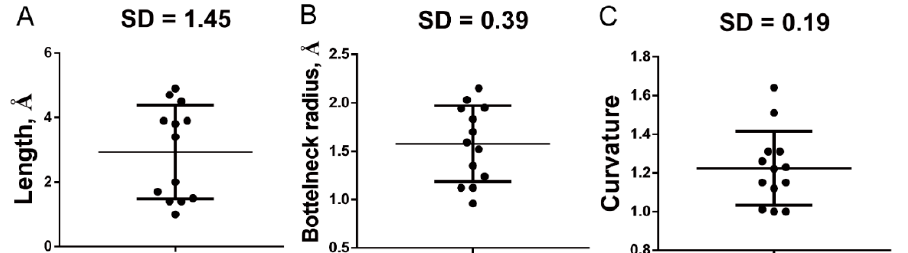
Figure 5. Shape parameters of the catalyzing pockets of structured rhodaneses. The rhodanese structures were downloaded from PDB database (Table S1). The length ( A ), bottleneck radius ( B ) and curvature ( C ) parameters of their catalyzing pockets were calculated using the Caver Analysis software (v2). Table 4. Structured rhodaneses downloaded from the PDB database.